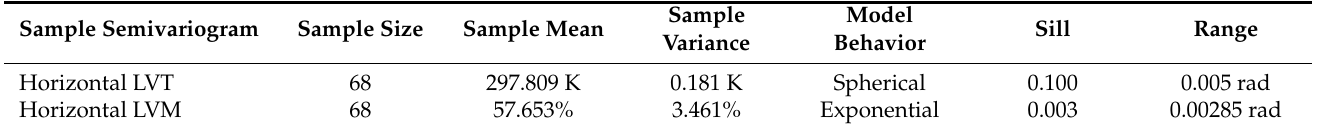
Table 3. Model horizontal sample semivariogram data.